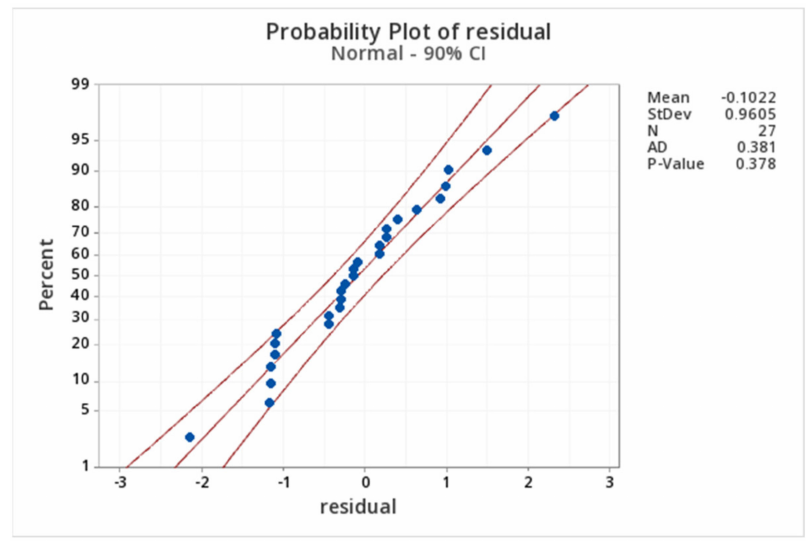
Figure A4. Normal probability plot of residuals for the effects on glycerol conversion.